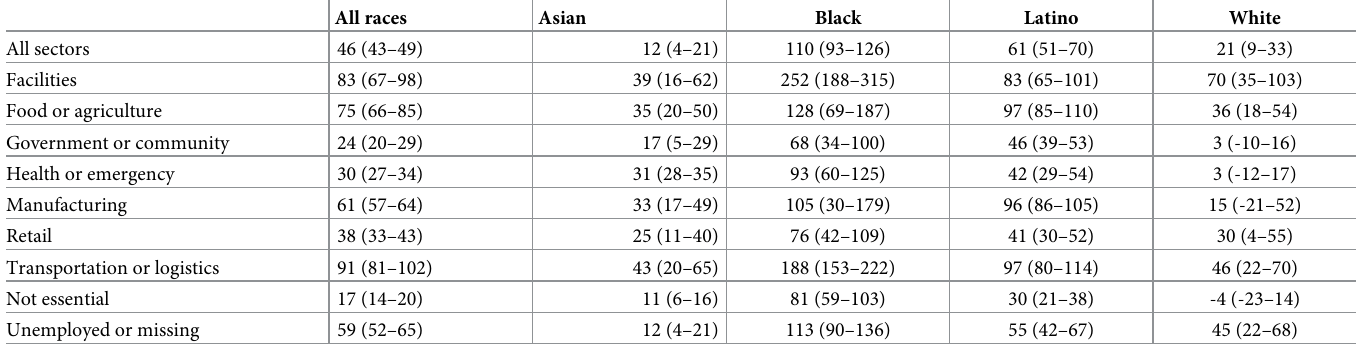
Table 3. Per-capita excess mortality among California residents 18–65 years of age, by occupational sector and race/ethnicity, March through November